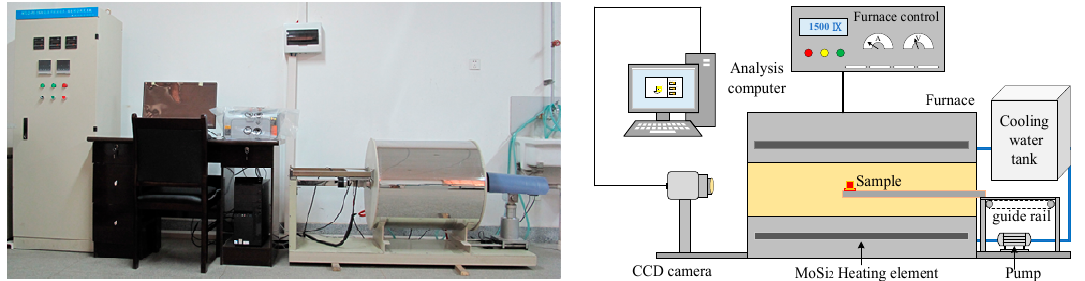
Figure 1. The schematic figure of melting-point and melting-rate comprehensive measurement system.